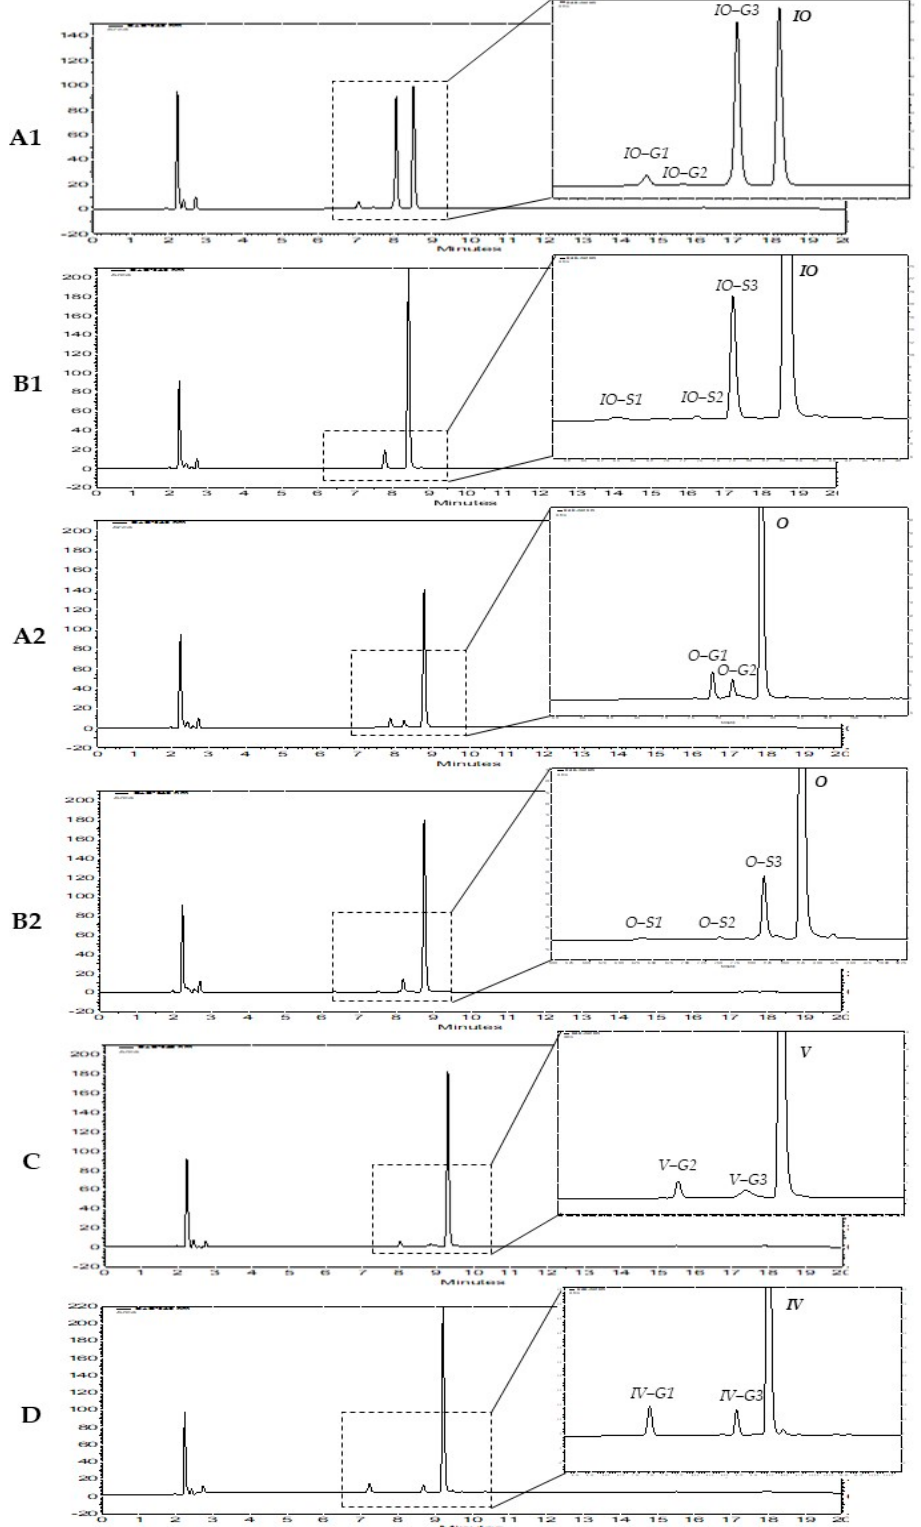
Figure 3. HPLC chromatograms of four flavone C-glycosides and their phase II metabolites: ( A1 ) IO and its metabolites (IO-G1/G2/G3) formed by HLM, ( B1 ) IO and its metabolites (IO-S1/S2/S3) formed by SULTs in liver S9 fraction, ( A2 ) O and its metabolites (O-G1/G2) formed by HLM, ( B2 ) O and its metabolites (O-S1/S2/S3) formed by SULTs in liver S9 fraction, ( C ) V and its main metabolites (V-G2/G3) formed by HLM, ( D ) IV and its main metabolites (IV-G1/G3) formed by HLM.